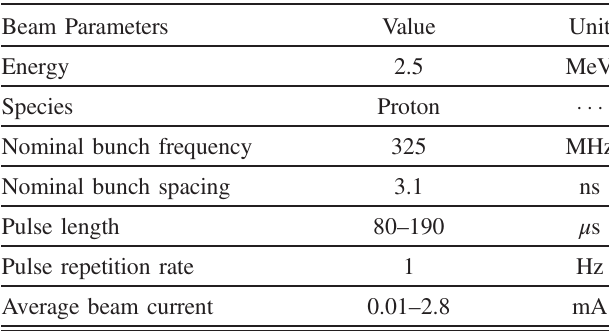
TABLE II. HINS beam